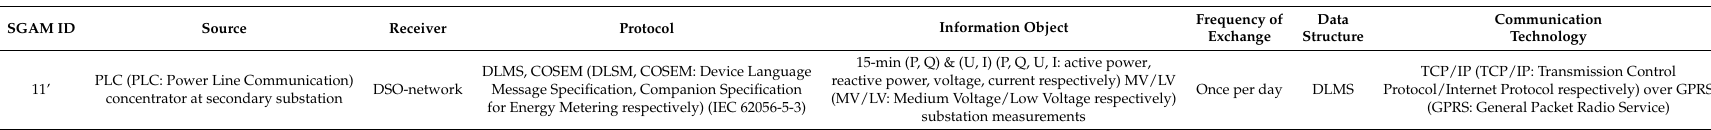
Table 1. SGAM ID table for the scenario analyzed in the paper (Large Customer Commercial VPP), merging and extending the component, information and communication